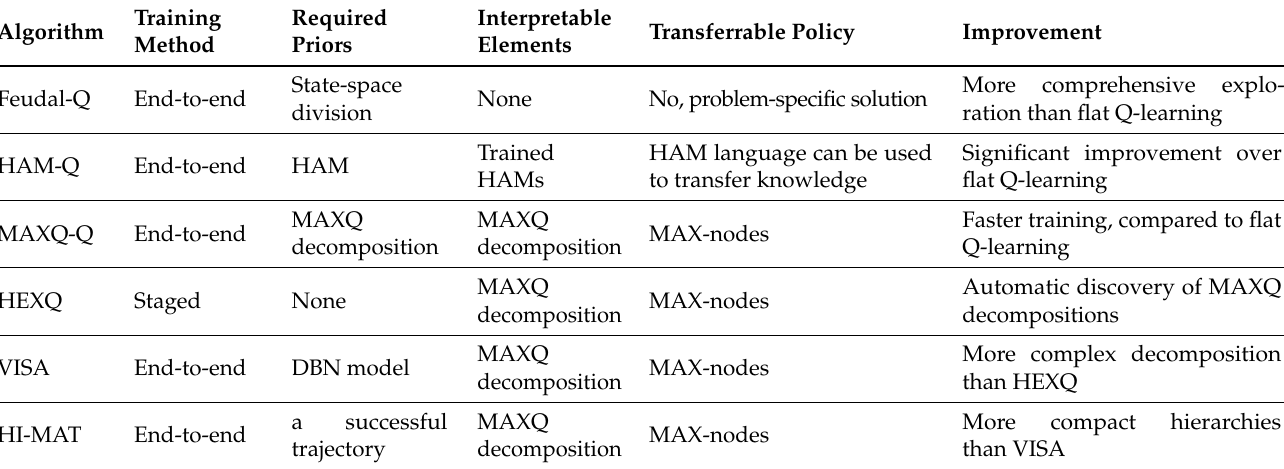
Table 2. Evaluation of problem-specific algorithms.